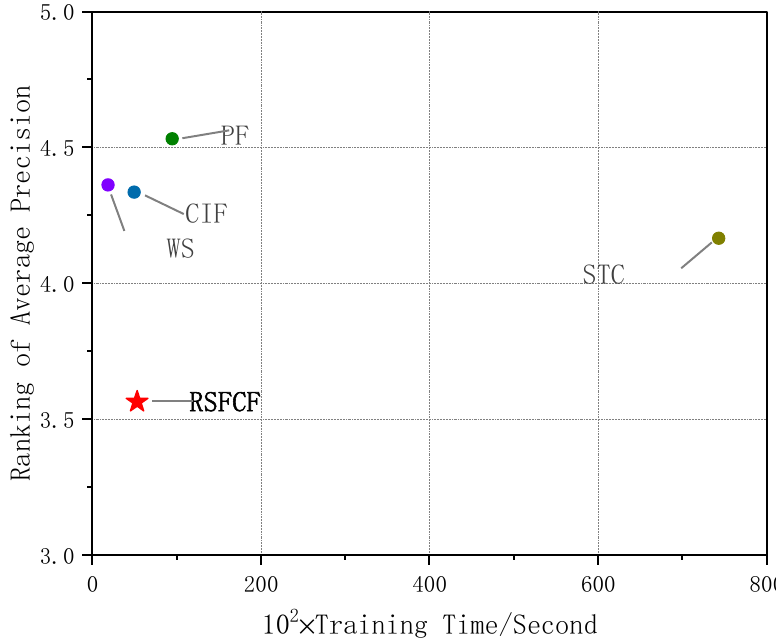
Figure 8. Comparison of RSFCF and 4 classifiers in terms of average training time and average ranks over Small60 datasets.